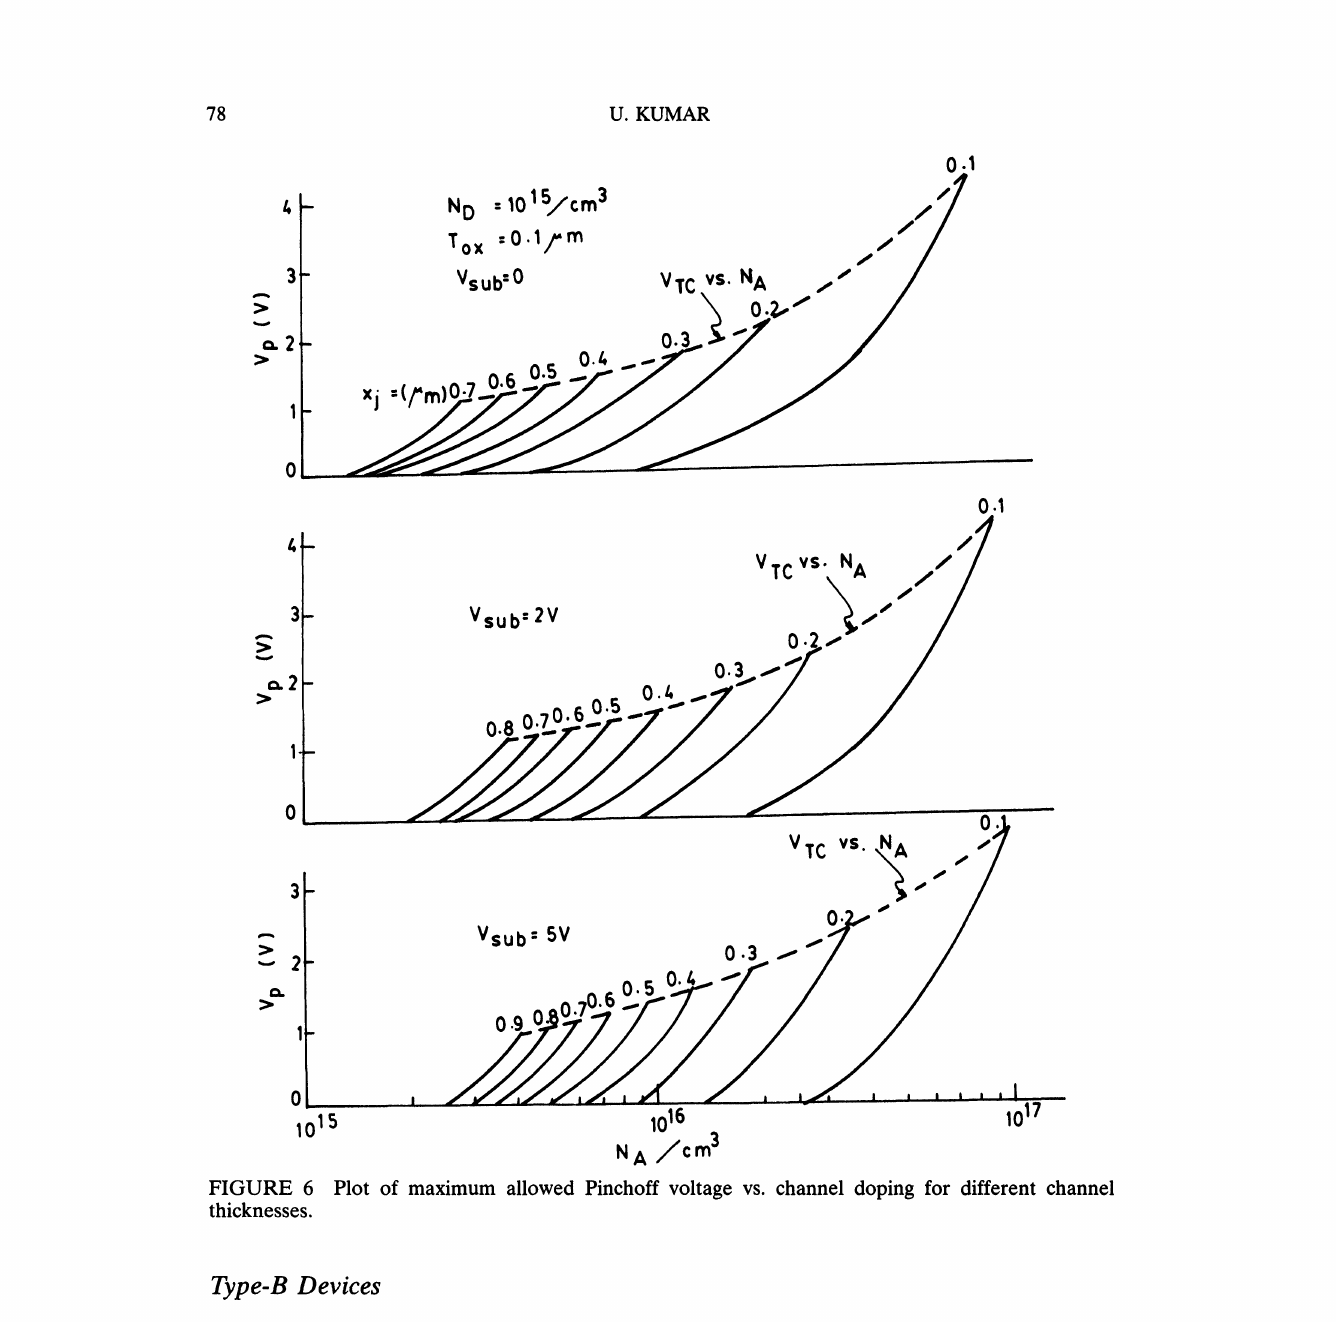
FIGURE 6 Plot of maximum allowed Pinchoff voltage vs. channel doping for different channel